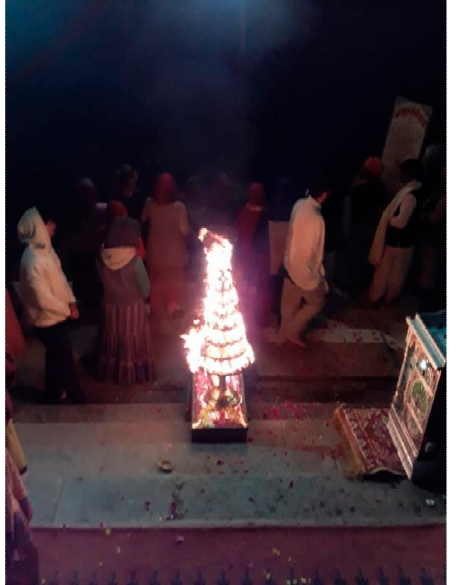
Figure 1. Brass-lampholder lit for the evening Yamuna Arati . Photo credit: Author (14 February 2019). This scene was saturated with material provocation for the senses—fire, camphor, flowers, water. This assembly was offering respect to a much ecologically damaged river.